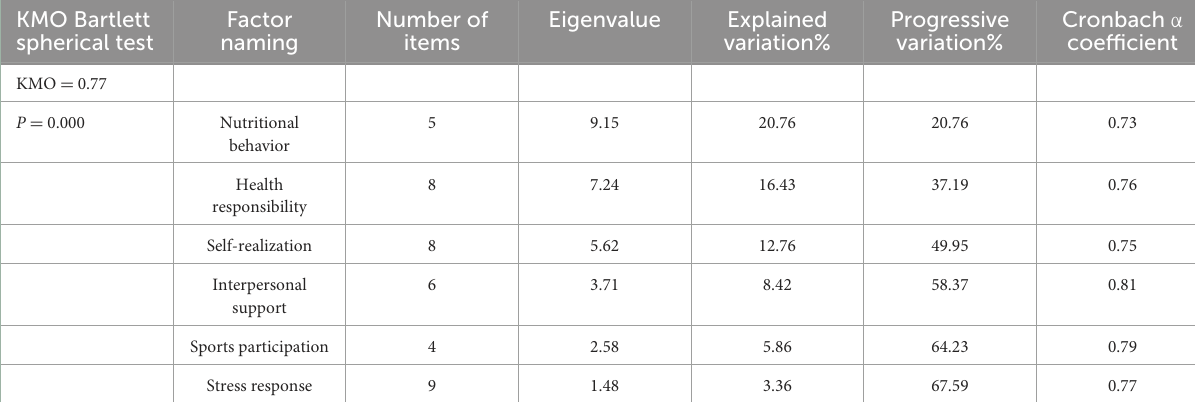
TABLE 1 Common factor extraction and reliability analysis of college students’ health promoting lifestyle scale. KMO Bartlett spherical test KMO =